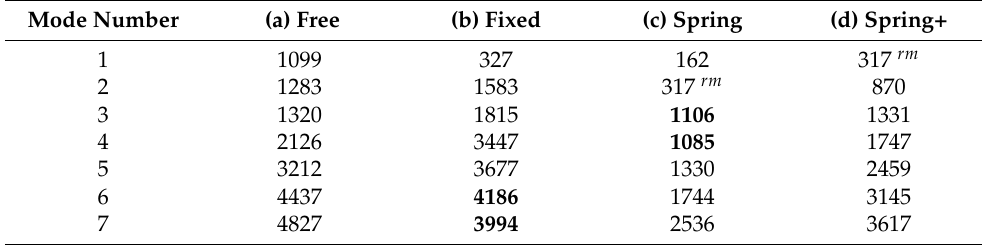
Table 3. Values of the first 10 natural frequencies (in Hz ) of Model 30 in different boundary conditions. Modes where the bridge moves rigidly are denoted with rm . Mode switches with respect to the Normal Model in the same boundary conditions are in bold. All mode shapes are available in Figures A3, A5, A7, and